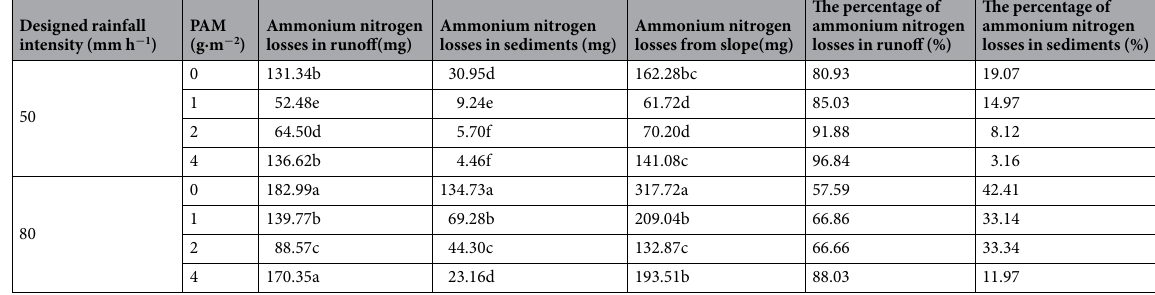
Table 2. The amount ammonium nitrogen losses in runoff and sediments and the proportion of nitrogen loss forms for each PAM application rate under different rainfall intensities.